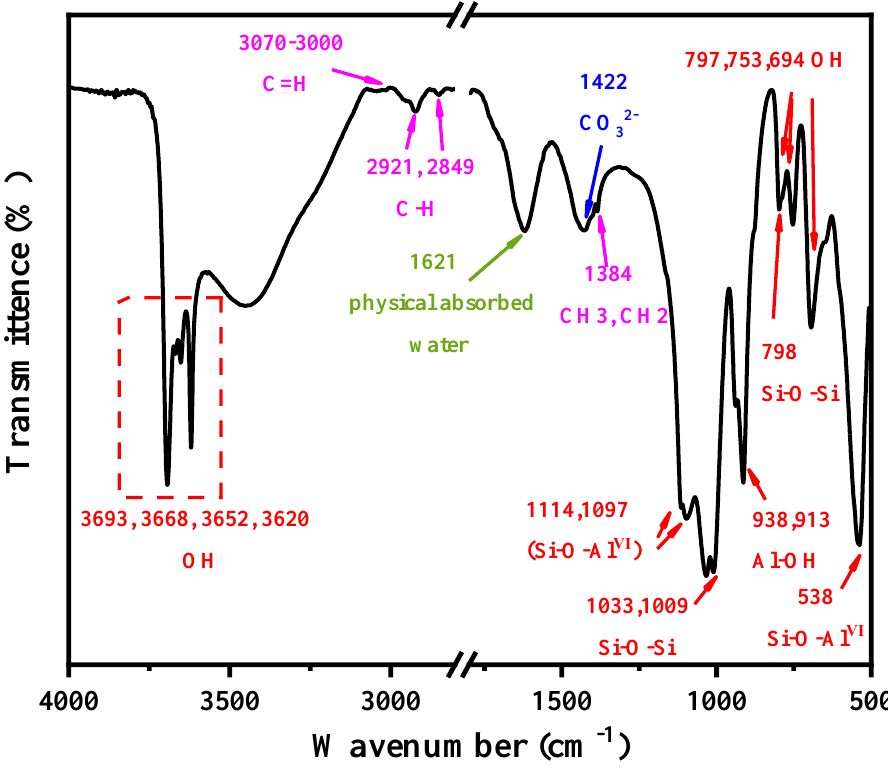
Figure 2. FTIR spectra of the KAS. Table 4. Characteristic absorption peaks of FTIR of kaolinite.